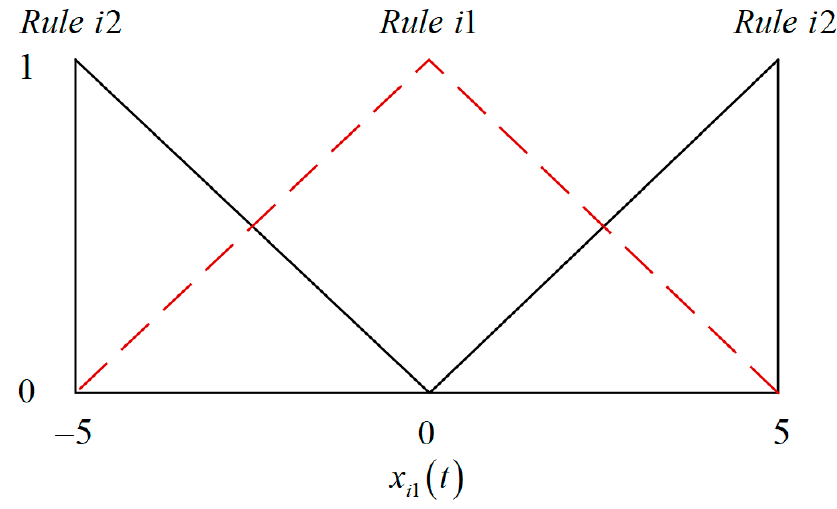
Figure 2. Membership functions for Simulation 4.1.